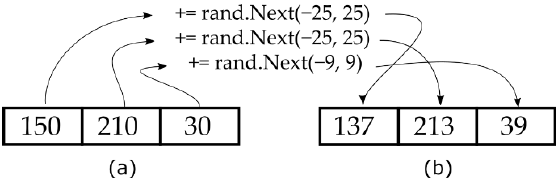
Figure 6. Rounded link gene mutation: ( a ) before; ( b ) after.